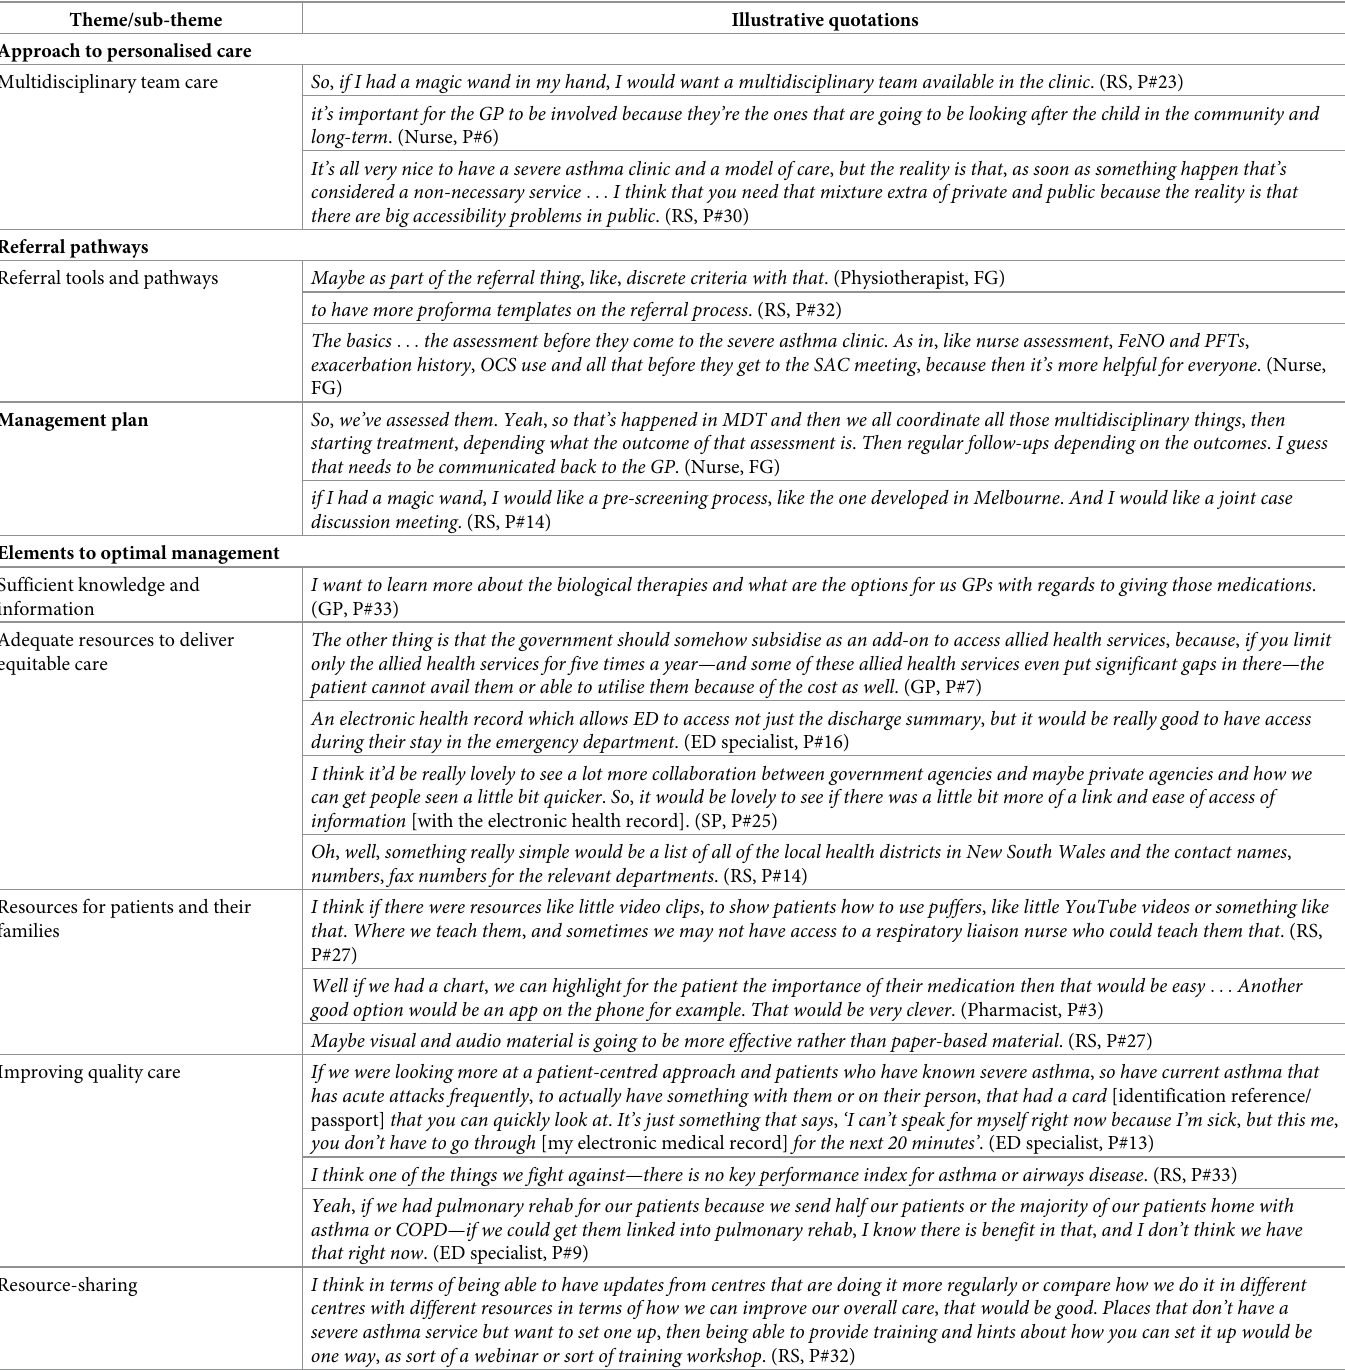
Table 5. Illustrative quotations regarding the desired model of care in severe asthma.